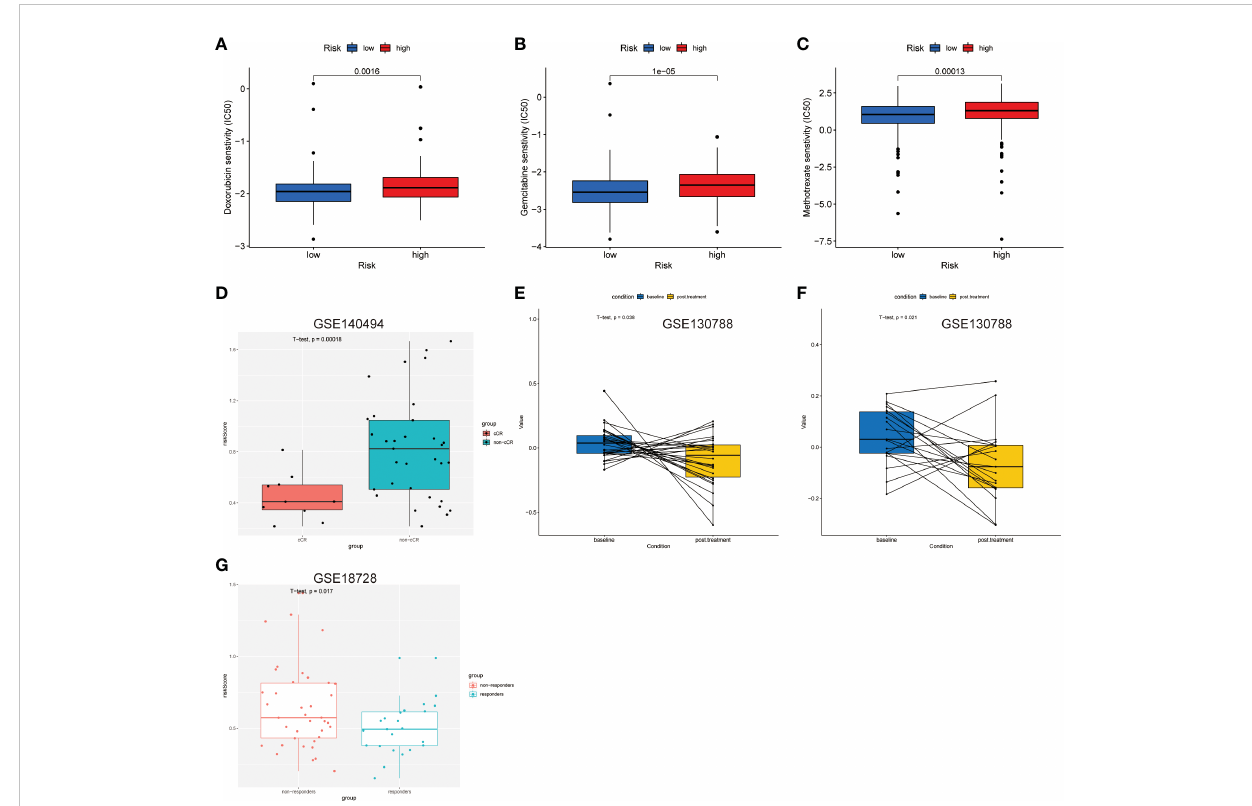
FIGURE 8 Predictive value of the LNPRS for chemotherapeutic ef fi cacy in the 4 independent cohorts. (A – C) In the TCGA cohort, the differences in sensitivity to chemotherapy drugs of patients with low and high LNPRS. (D, G) The boxplot shows the difference in the LNPRS for breast cancer patients with different responses to neoadjuvant chemotherapy in the GSE140494 (D) and GSE18728 (G) cohorts. Signi fi cance was determined by a t-test. (E, F) Pairwise comparison of the LNPRS in breast cancer patients pre- and postchemotherapy for the GSE130788 cohort by the pairwise